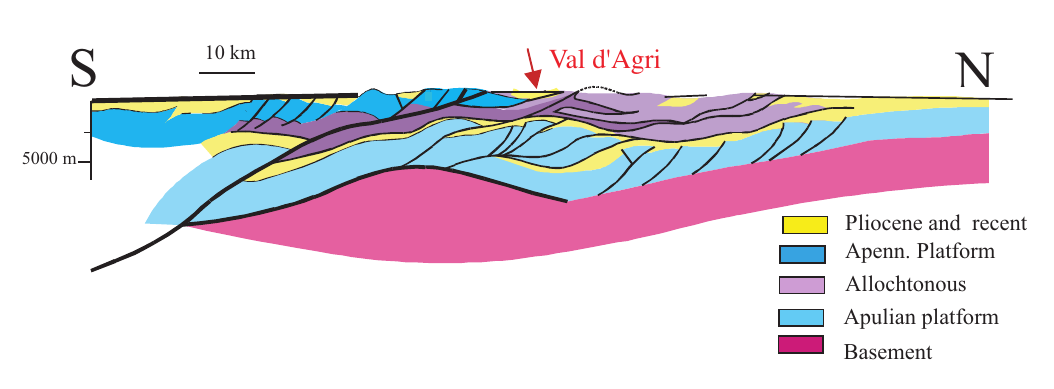
Fig. 1. Geological cross section across Southern Apennines.